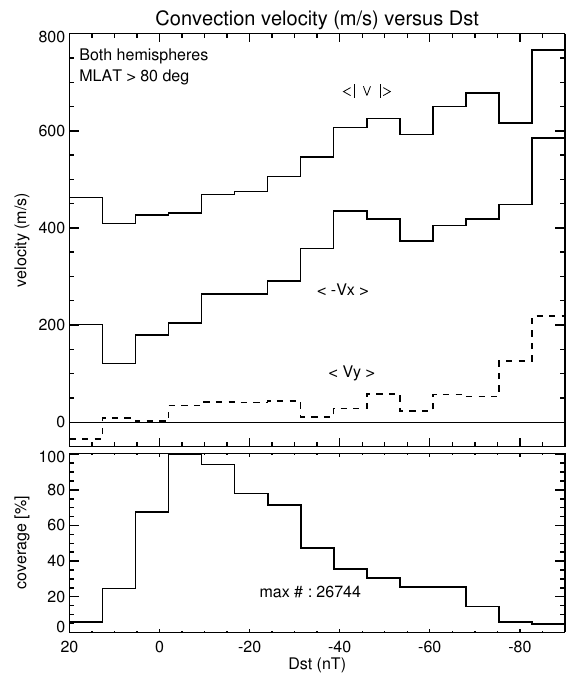
Fig. 12. Top: Dependence of the average convection velocities on the D st index, with data from both hemispheres combined. Bottom: number of data points with equally sized steps, in percentage of the maximum indicated.